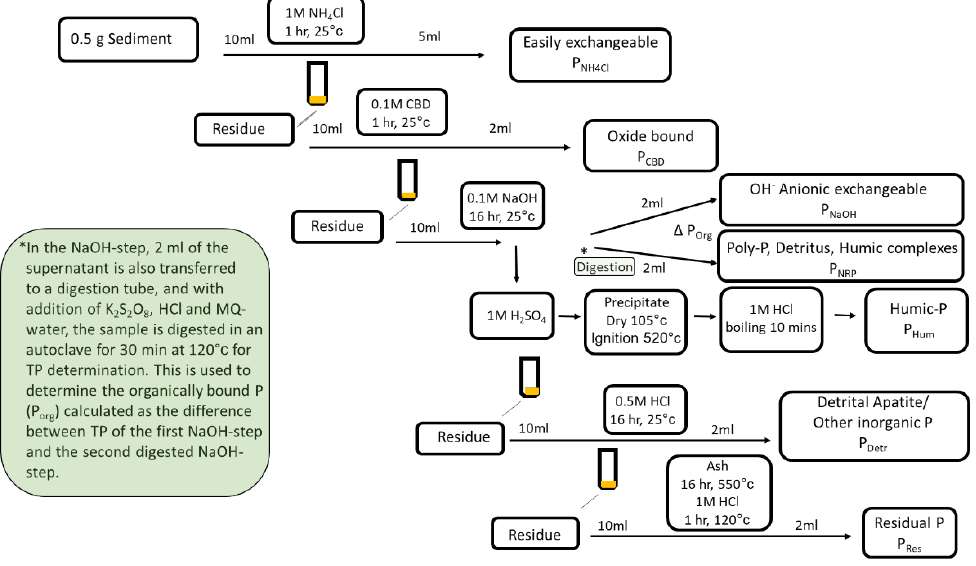
Figure 2. Modified Psenner sequential chemical P extraction procedure flow diagram [16,32].